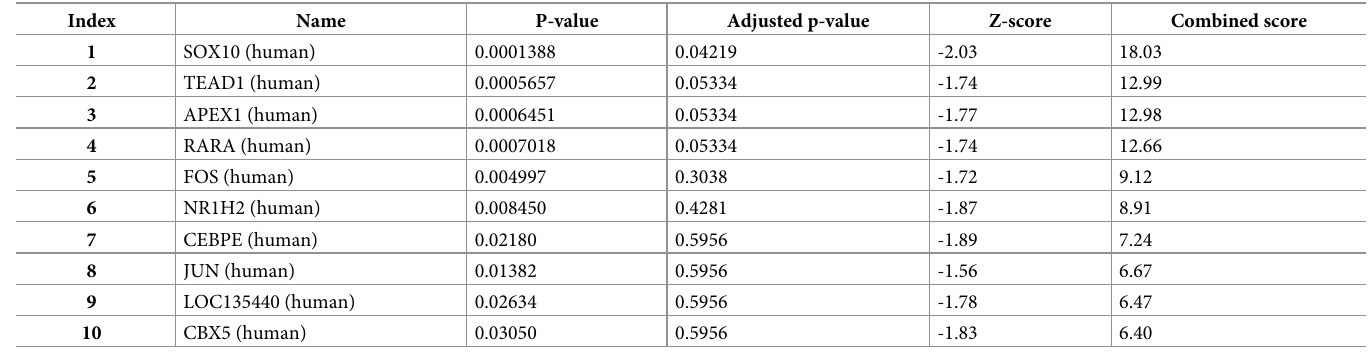
Table 2. Significant transcription factor binding sites associated with DRGs.